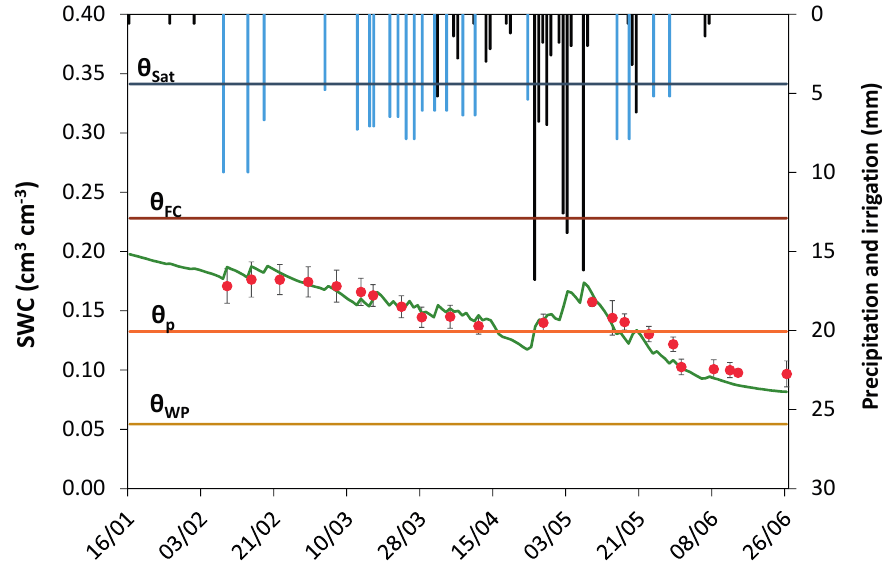
Figure 2. Observed (  ) and simulated ( —– ) daily soil water content (SWC) after the calibration of SIMDualKc for barley in the dry year (error bars correspond to the standard deviation of SWC observations); θ Sat , θ FC , θ p and θ WP are respectively the SWC at saturation, field capacity, wilting point and at non-stressed depletion fraction